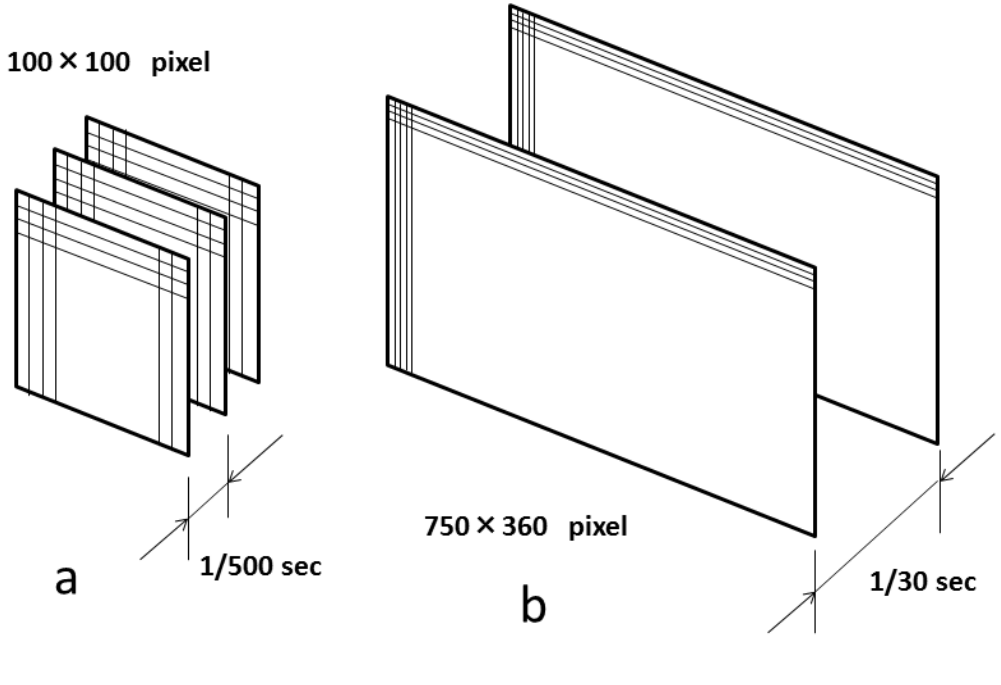
Figure 1. Comparison of the sampling rate and area of the area sensor used in the original laser speckle flowgraphy (LSFG) system ( a ) and the charge-coupled device (CCD) camera used in the LSFG-NAVI system ( b